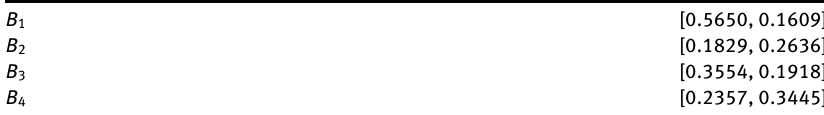
Table 10: Aggregating Matrix on Intuitionistic Fuzzy Power Averaging. B